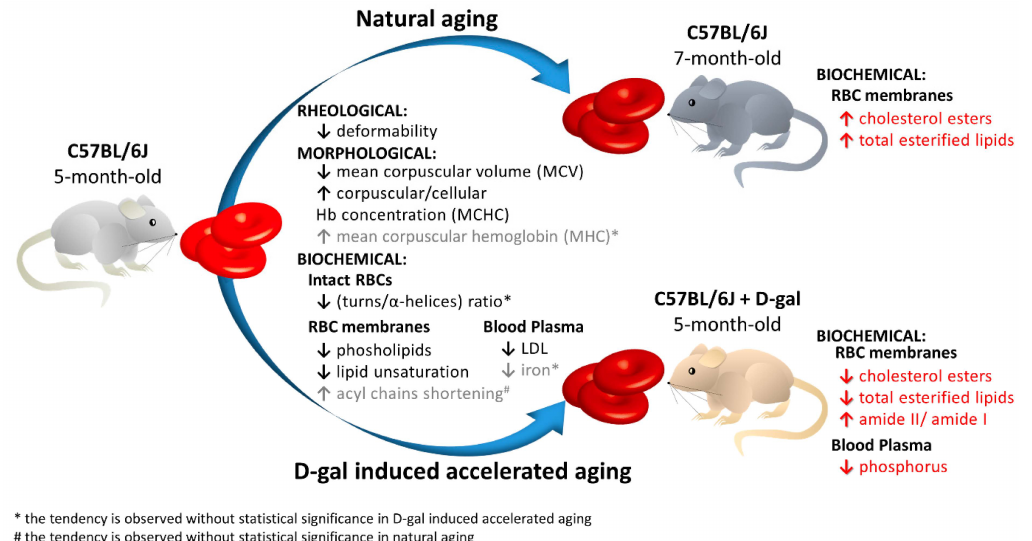
Figure 6. Schematic diagram of the RBC changes during natural aging compared with accelerated aging induced by